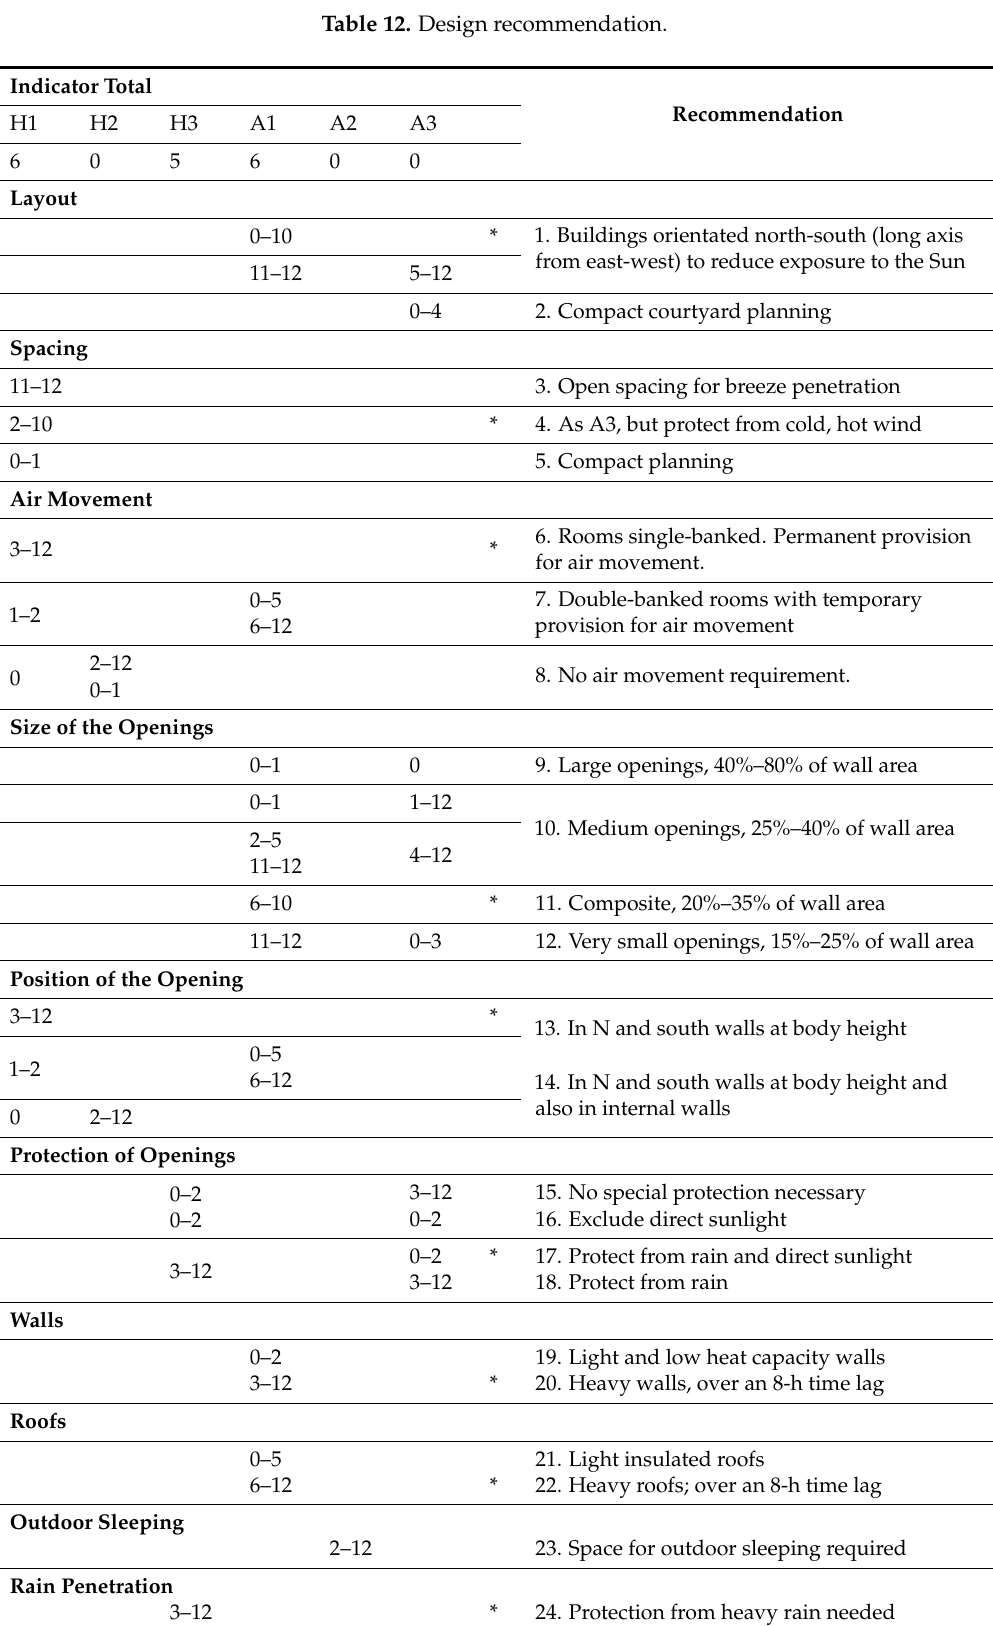
Table 12. Design